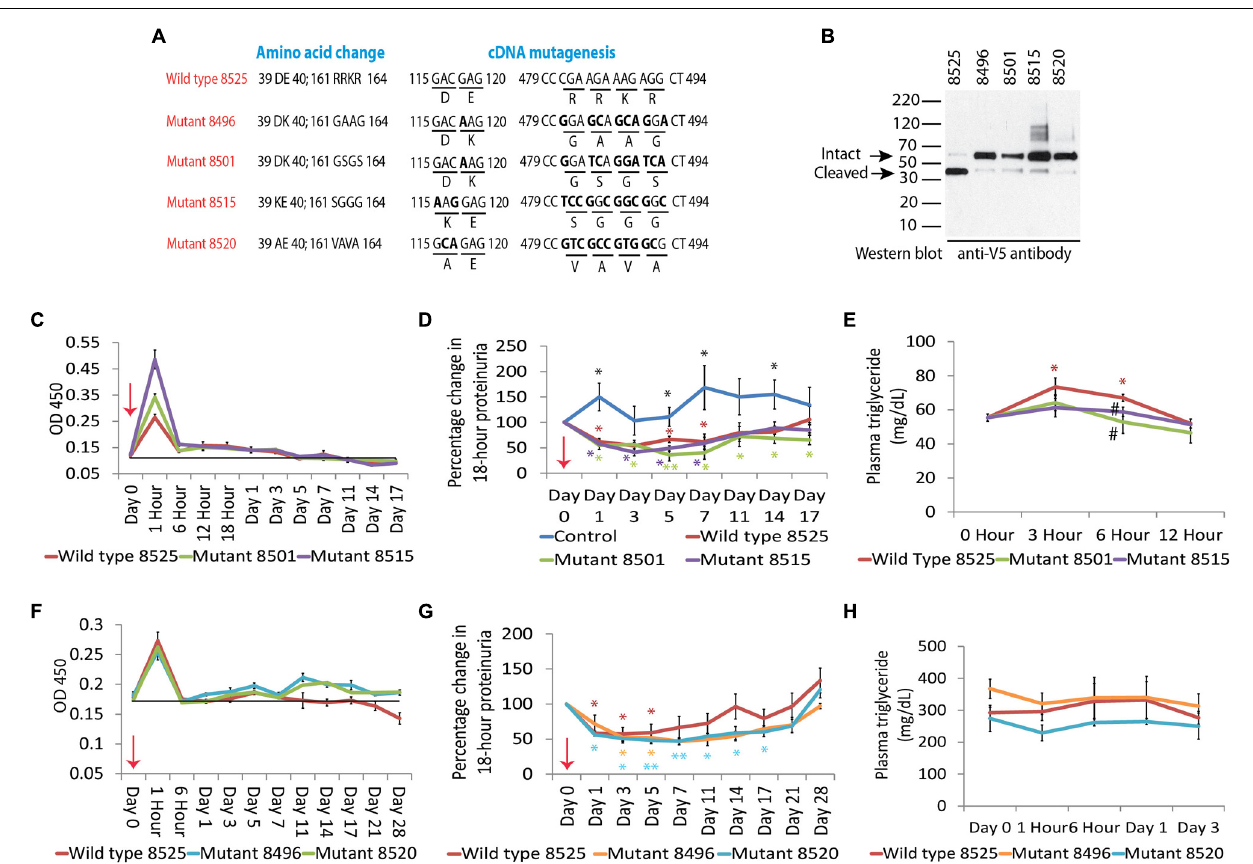
FIGURE 5 | (A) Schematic representation of wild type and mutant human Angptl4 proteins showing mutations in areas important for LPL binding (amino acid 40, and adjacent amino acid 39) and protein cleavage (amino acids 161 to 164). (B) Western blot of recombinant tagged proteins using mouse antiV5 antibody to demonstrate the expected size of the intact protein and reduced cleavage in the mutant proteins (arrows). (C) Plasma levels of wild type (8525) or mutant (8501, 8515) human Angptl4 in Buffalo Mna rats ( n = 3 rats/group) after injecting 55 μ g of recombinant human protein as assessed by OD 450 using reagents from the human Angptl4 ELISA kit. (D) Effect of injecting wild type and mutant Angptl4 on proteinuria in Buffalo Mna rats. (E) Effect of injecting wild type and mutant Angptl4 on plasma triglyceride